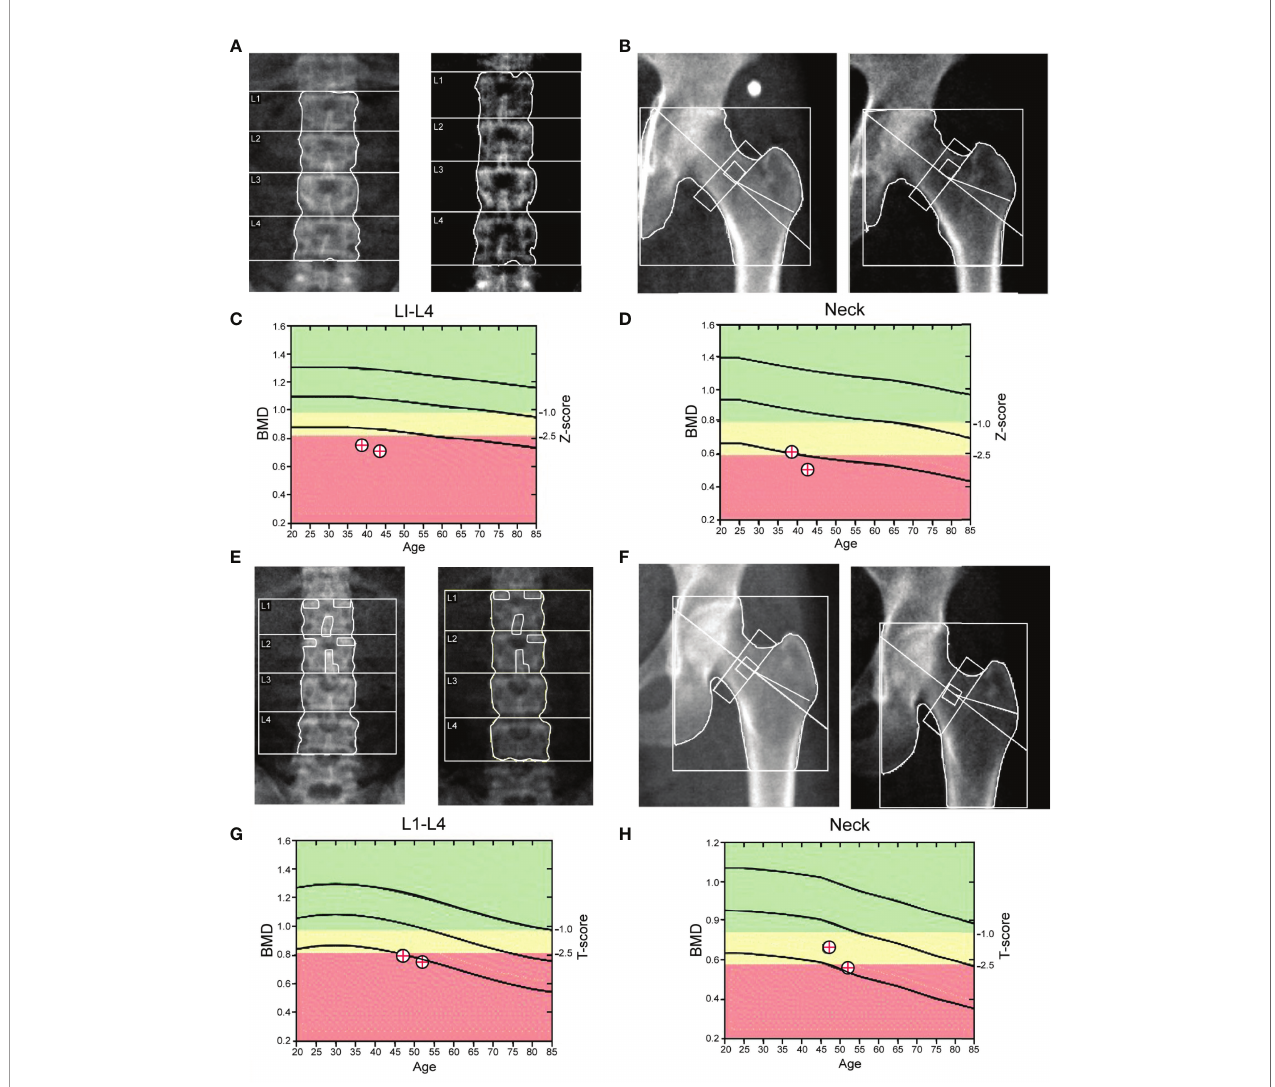
FIGURE 1 | DXA scans of the lumbar spine and femoral neck. (A – D) Homozygous man (38 years); the Z-scores for lumbar spine (L1 – L4) and femoral neck DXA were -3.0 and − 1.9, respectively. The diagnosis by DXA was osteopenia. During the follow-up, the Z-scores for the lumbar spine (L1 – L4) and femoral neck DXA were -3.3 and − 2.2, respectively. (E – H) Homozygous woman (47 years). The T-scores for the lumbar spine (L1 – L4) and femoral neck DXA were -2.6 and -1.7, respectively. The diagnosis by DXA was osteopenia. During the follow-up, the T-scores for the lumbar spine (L1 – L4) and femoral neck DXA were -3.1 and − 2.4,